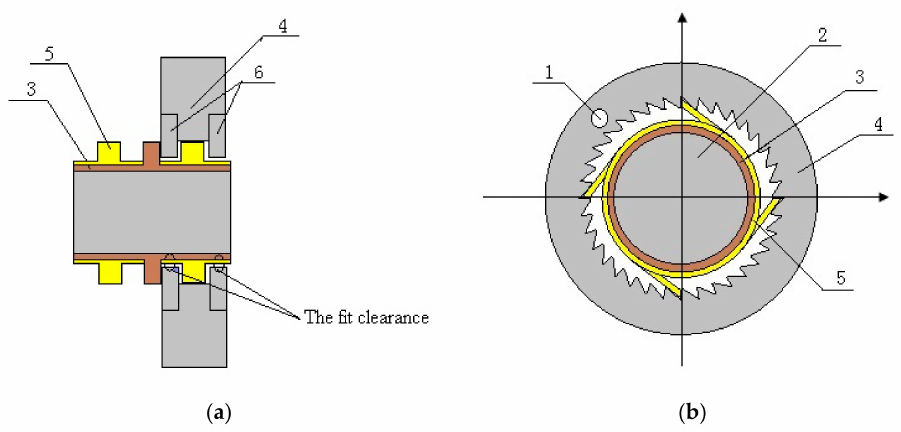
Figure 7. The compensation principle of the fit clearance. ( a ) The fit condition between balance disk and spindle; ( b ) The four claws structure of balance disk. Notes: 1 unbalance mass; 2 spindle; 3 double-shoulder sleeve; 4 balance disk body; 5 installing ring; 6 side